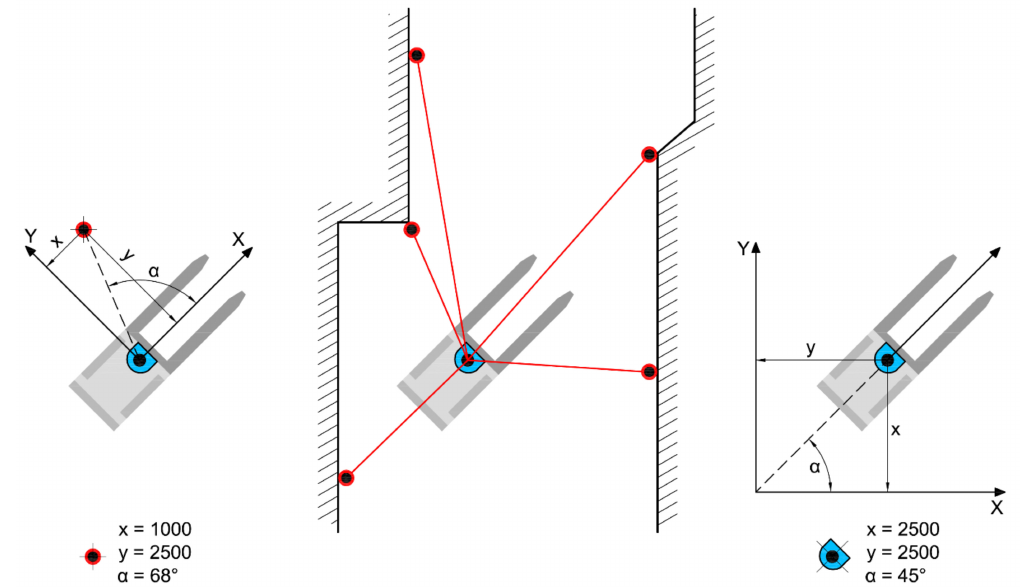
Figure 2. Basic sketch of the determination of the relative position between the reference mark and the vehicle ( left ) and the absolute position in the coordinate system ( right ) (Adapted after SICK AG, in [5]).